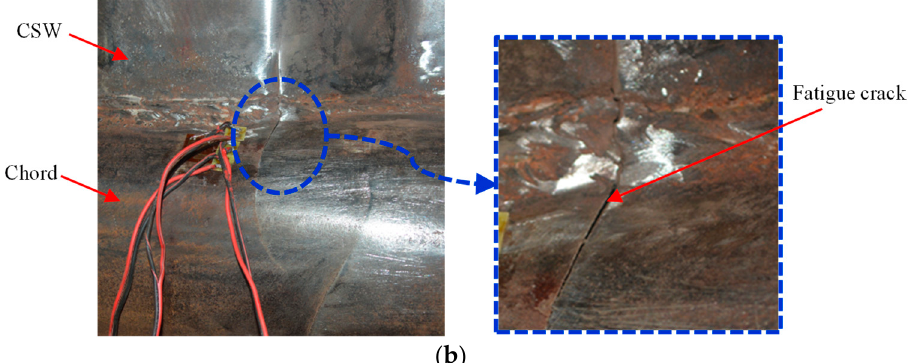
Figure 9. Developing process of fatigue crack: ( a ) developing process; ( b ) fatigue crack.